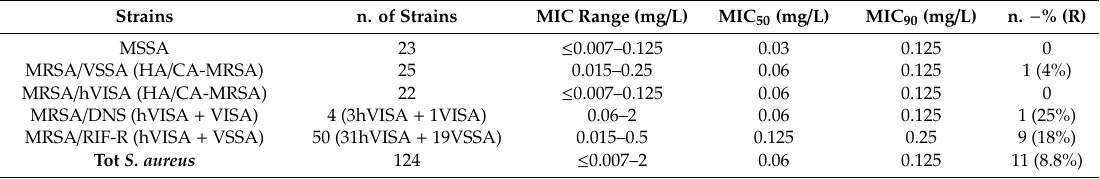
Table 1. In vitro activity of dalbavancin versus methicillin-susceptible Staphylococcus aureus (MSSA) and methicillin-resistant Staphylococcus aureus (MRSA) (vancomycin-susceptible S. aureus (VSSA), vancomycin-intermediate S. aureus (hVISA) and vancomycin-intermediate S. aureus (VISA); daptomycin non-susceptible (DNS) and rifampicin-resistant (RIF-R) represented as MIC range (mg / L), MIC 50 / MIC 90 and n / % of resistant isolates